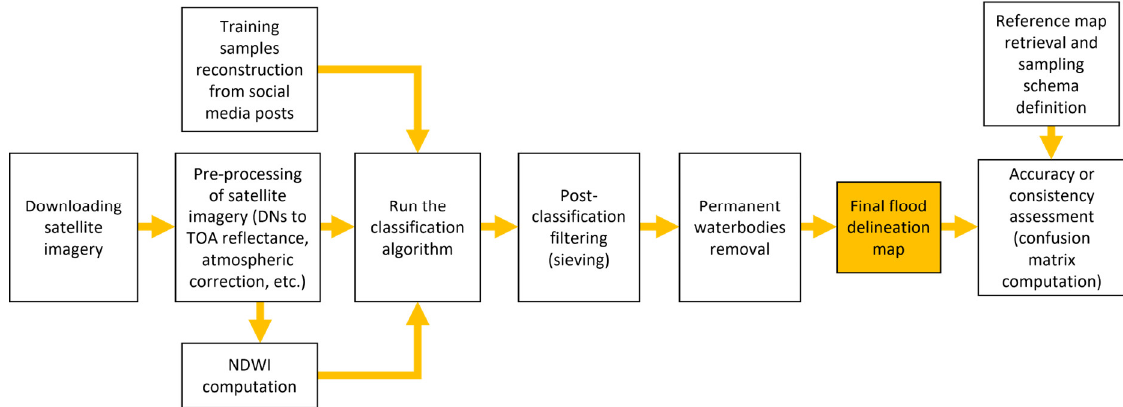
Figure 6. Workflow adopted for flood delineation mapping.